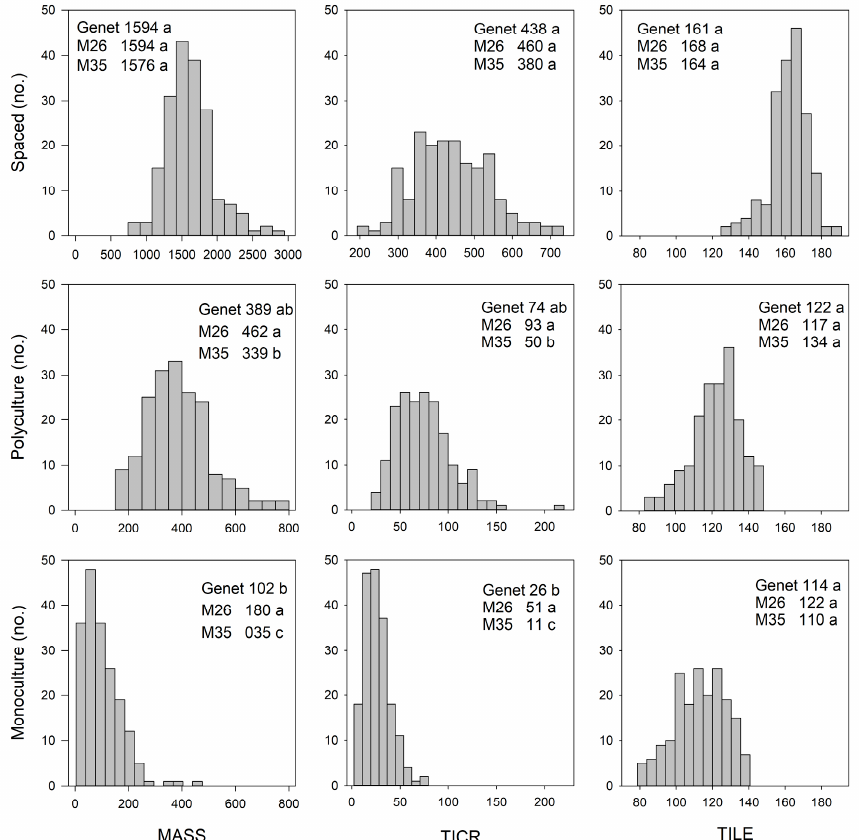
Figure 2. Range and frequency of biomass (MASS), tillers crown − 1 (TICR), and tiller length (TILE) for 192 full-sib progeny (genets) of the M26 × M35 intermediate wheatgrass mapping population evaluated over two years (2016–2017) at Logan, UT, USA in three clonally replicated competition environments (spaced-plants, grass − alfalfa polyculture, and grass monoculture). The genet and parent mean values followed by a di ff erent letter (a, b, c) are significantly di ff erent than each other at the 0.05 level of